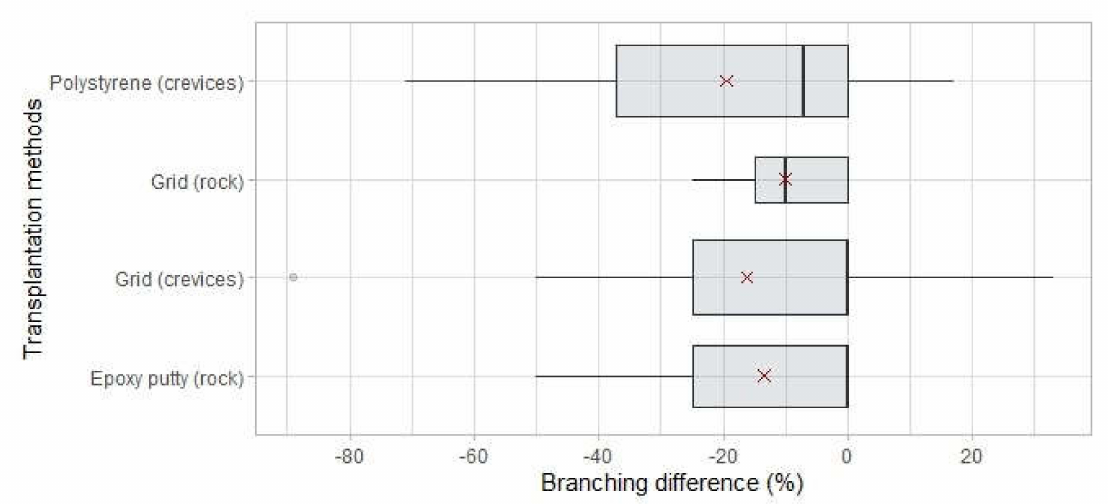
Figure 6. Change in the number of branches (branching difference, in percentage) of C. rubrum transplants for each transplantation method in Gallinara Island. The red cross represents the average. Boxes’ width is relative to the number of transplants.